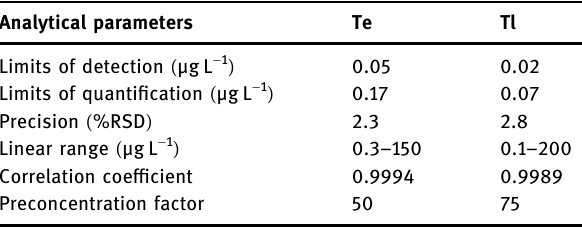
Table 4: Analytical parameters investigated for the performance of the